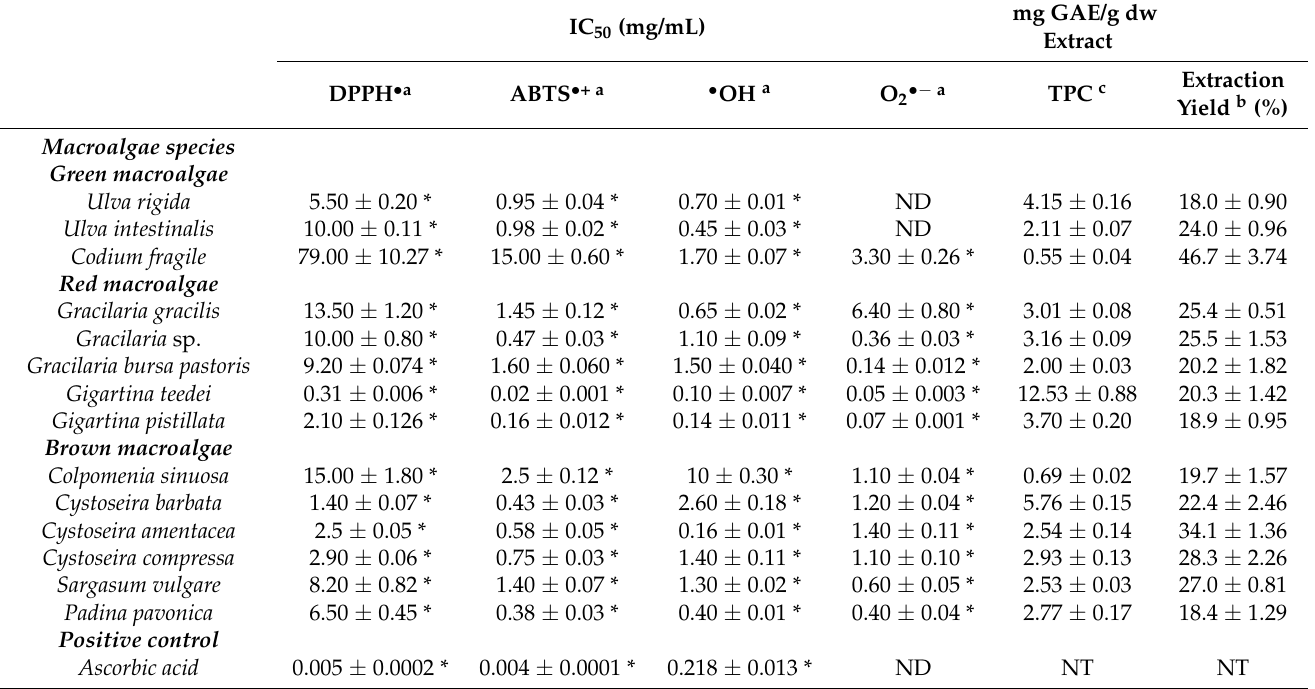
Table 2. Extraction yields of macroalgae extracts and their total polyphenols and IC 50 values